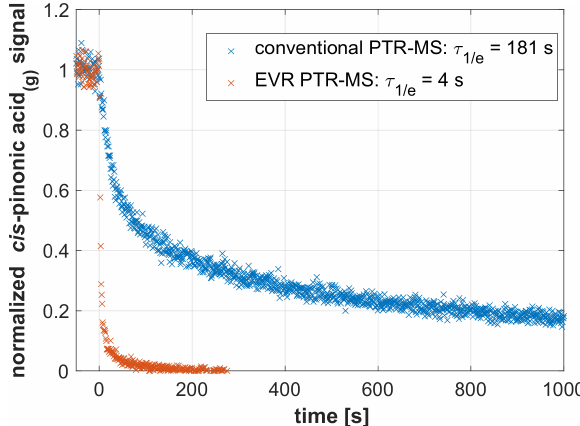
Figure 2. Signal decay as observed in a conventional PTR-MS in- strument ( T drift = 100 ◦ C; in blue) and in an EVR PTR-MS ana- lyzer ( T drift = 100 ◦ C; in red) after a steady supply of gaseous cis - pinonic acid was instantly switched off at t =